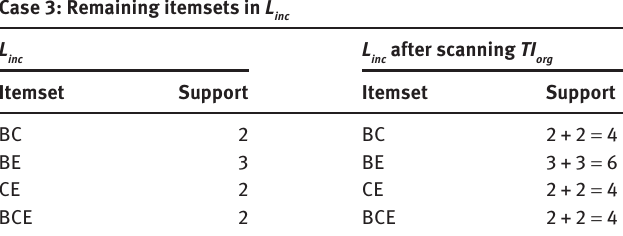
Table 9: Frequent Itemsets in Case 3.